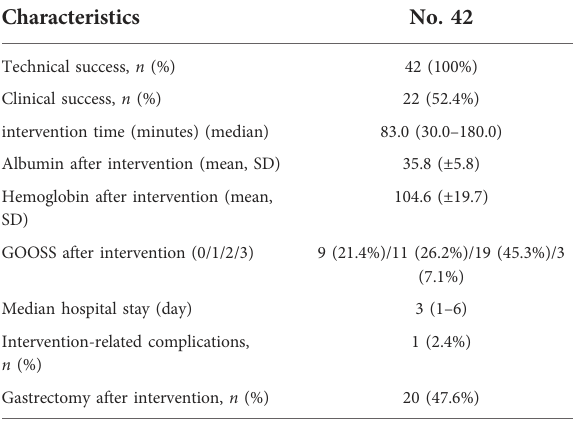
TABLE 2 Ef fi cacy and complications.